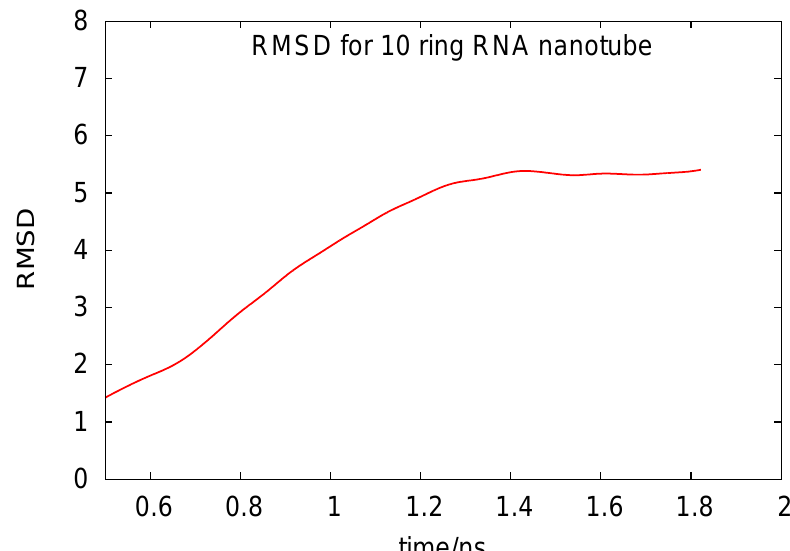
Figure 4. Root mean square deviation for the 10-ring RNA nanotube under coarse-grained model approximations.